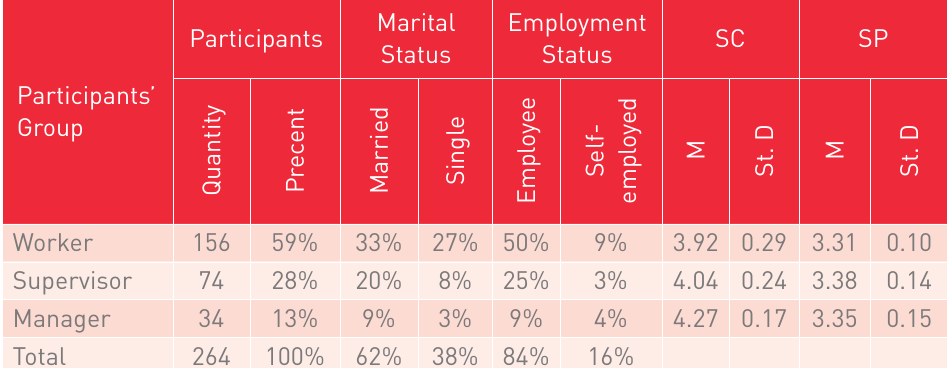
Descriptive statistics of the safety survey